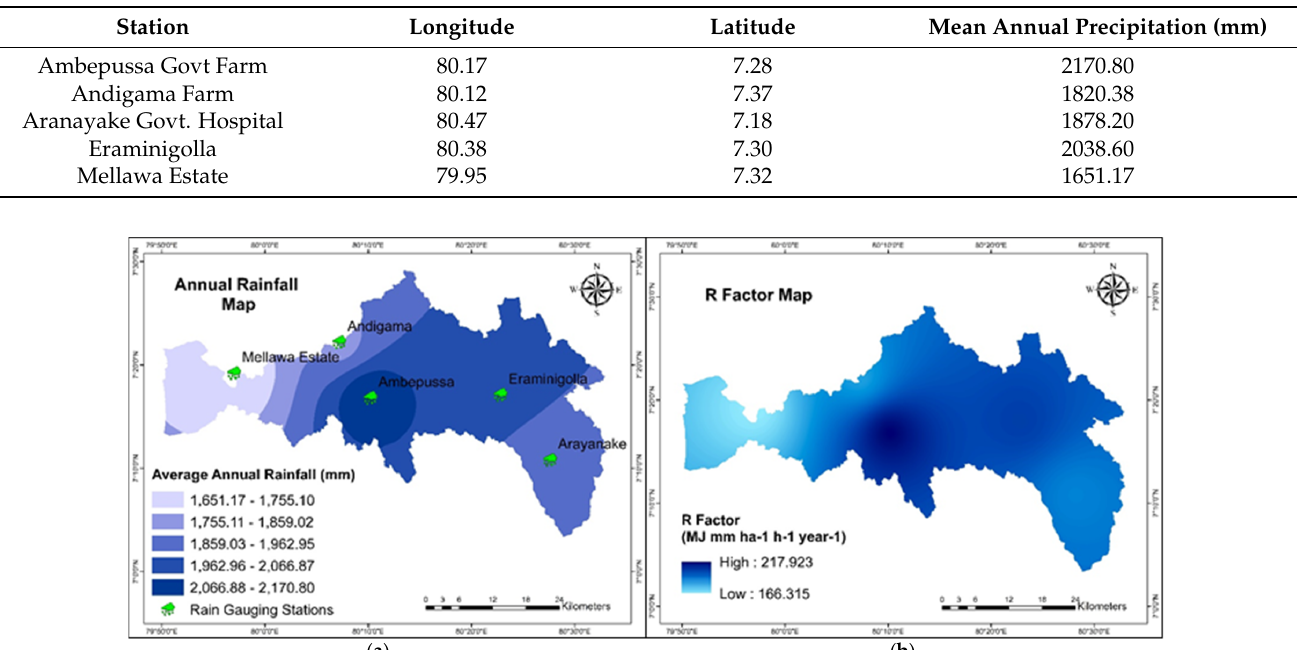
Table 8. Mean annual precipitation of the rain gauging stations in Maha Oya River Basin.